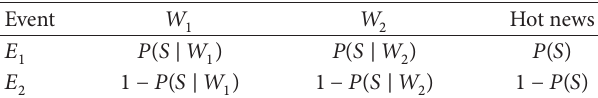
Figure 2: Distribution of news number for 55 different news websites. Table 2: Vocabulary with high weight existing probability and hot news